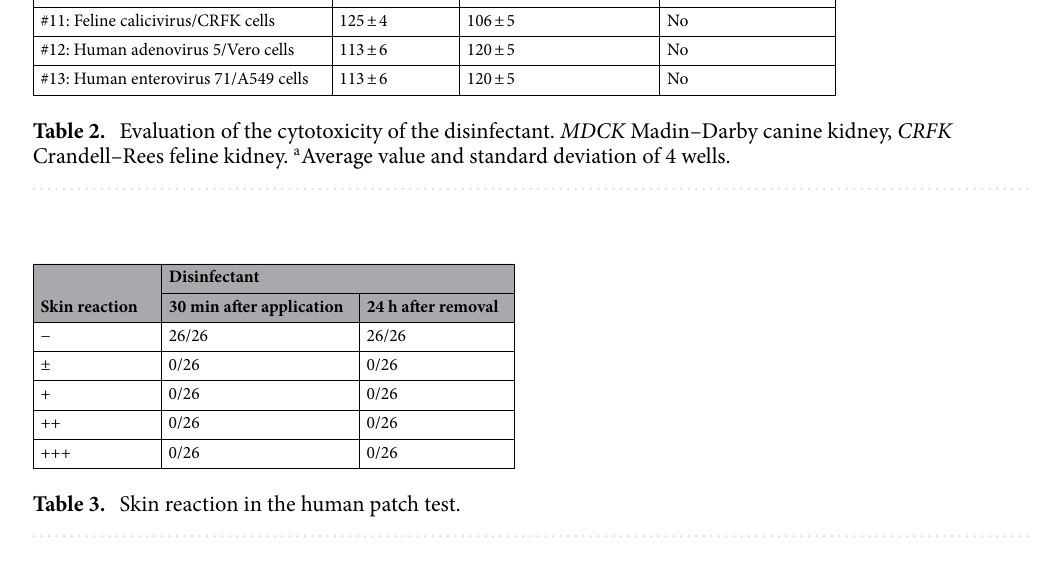
Pathogens/cell lines